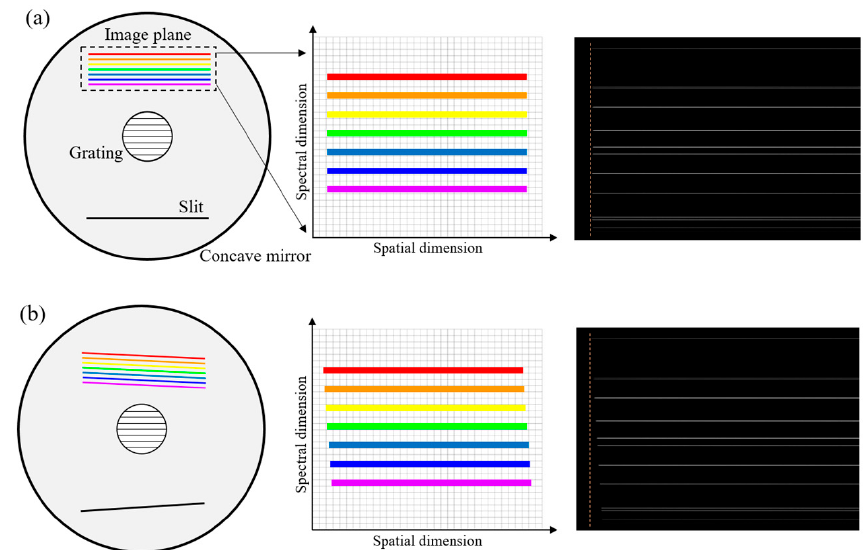
Figure 15. Slit-to-grating rotation affects the spatial uniformity of spectral image. The slit is parallel to the grating groove in ( a ), and the dispersion direction is perpendicular to the monochromatic slit images. The slit rotates an angle relative to the grating groove in ( b ), and the dispersion direction is not perpendicular to the monochromatic slit images.